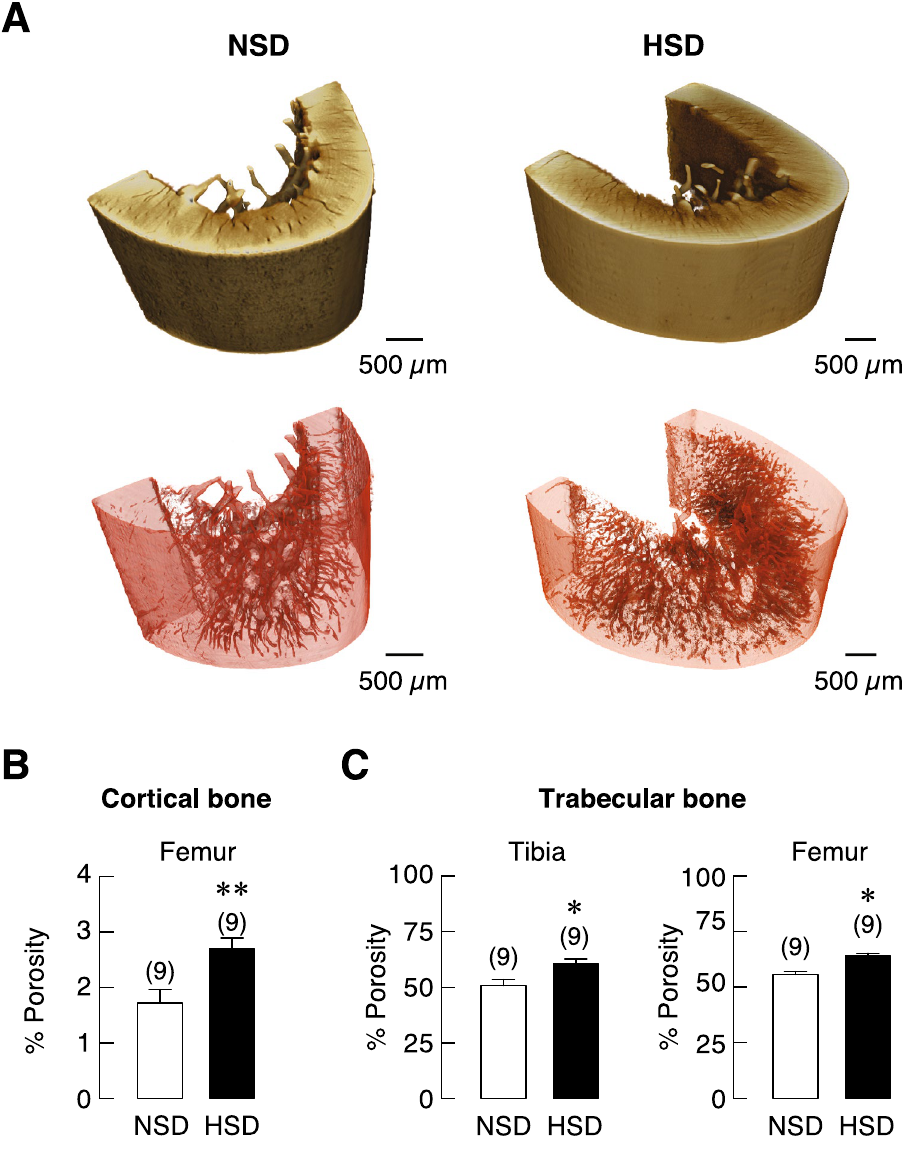
Figure 5. The segmentation and analysis for pore measurement in the 3D volumes of cortical bone specimens obtained from SRXTM. ( A ) 3D volume representatives of the cortical bone at diaphysis of femur from NSD and HSD group are shown in brown color gradient. The segmentation of pore canals inside the bones is rendered in red color enclosed with a transparent background for porosity measurement. All scale bars are depicted 500 µm. ( B ) quantitative analyses of the porosity of cortical bone at diaphysis of femurs and ( C ) trabecular bone at proximal metaphysis of tibiae and trabecular bone at distal metaphysis of femurs. The number of animals in each group are indicated in parentheses. * P < 0.05, ** P < 0.01 compared to